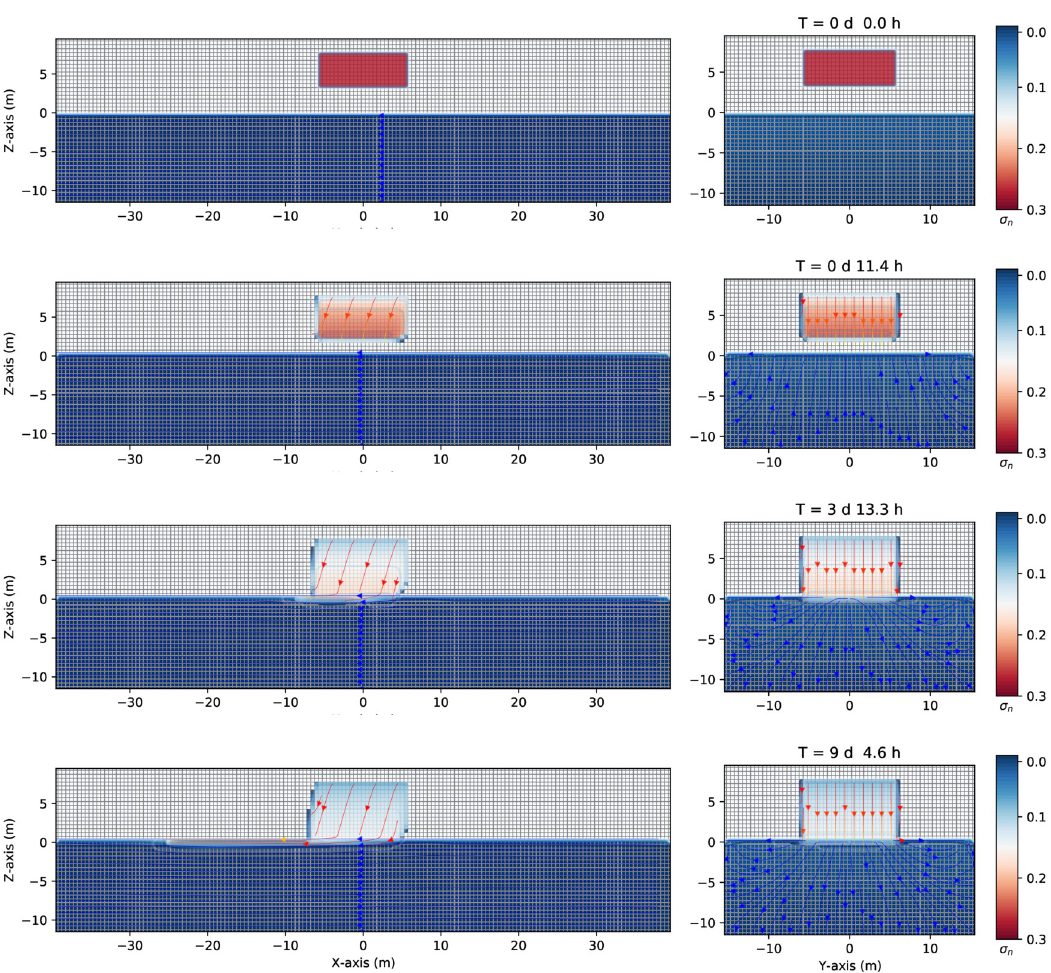
Fig 10. Saturation contours of LNAPL (small source) at different times. Three-dimensional numerical simulation results of the saturation contours ( σ = S ) of a three-phase immiscible fluid flow (water + a small volume source of LNAPL + air) using a spatial n n ϕ grid resolution of 0.50 m and a grid dimension of 80 m × 32 m × 22 m , at different times. Notice how the LNAPL migrates through the saturated zone while moving in the left direction due to a pressure gradient and remains entirely on the capillary fringe zone.